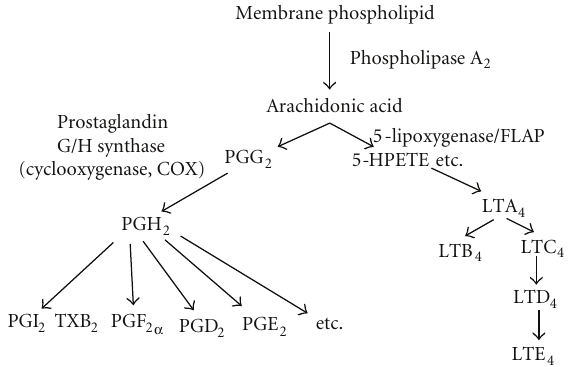
Figure 1: Diagram of arachidonic acid